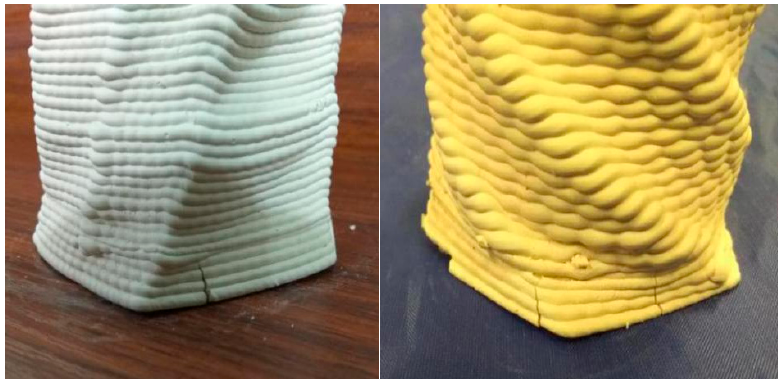
Figure 6. Cracks due to nonuniform drying.